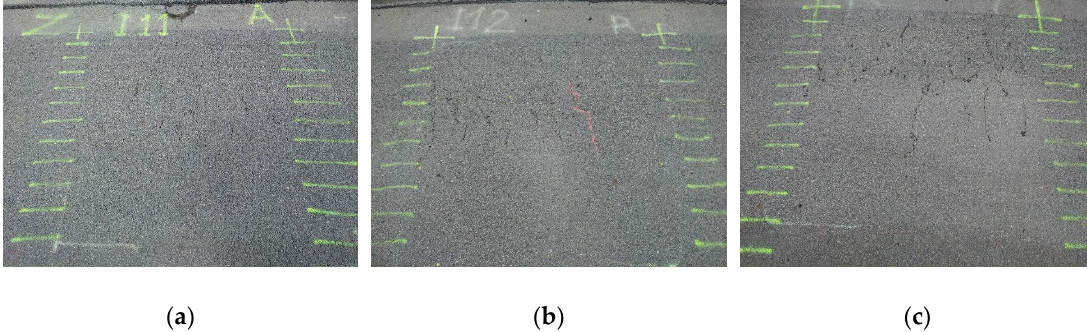
Figure 6. Photographs of defects ( a ) I-11 (sand), ( b ) I-12 (geotextile), and ( c ) I-13 (tack-coat free), at stage 800 K loadings. Paints correspond to the presumed longitudinal limits of the defects.